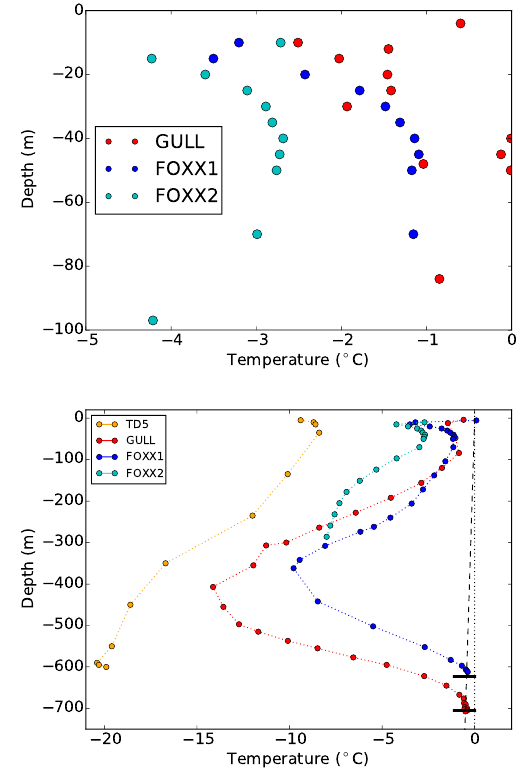
Figure 2. Measured ice temperatures. (a) shows near-surface tem- peratures at sites GULL and FOXX. Holes FOXX1 and FOXX2 are 86m apart. (b) shows measured ice temperatures in four boreholes at the drill sites TD5 (Swiss Camp; data from Thomsen et al., 1991), GULL and FOXX. The dashed line indicates the pressure melting